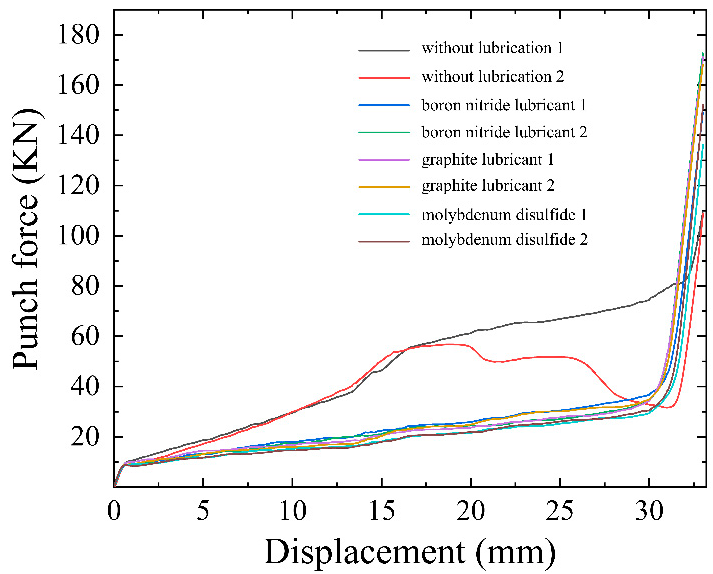
Figure 6. Force–displacement curves under different lubrication conditions.